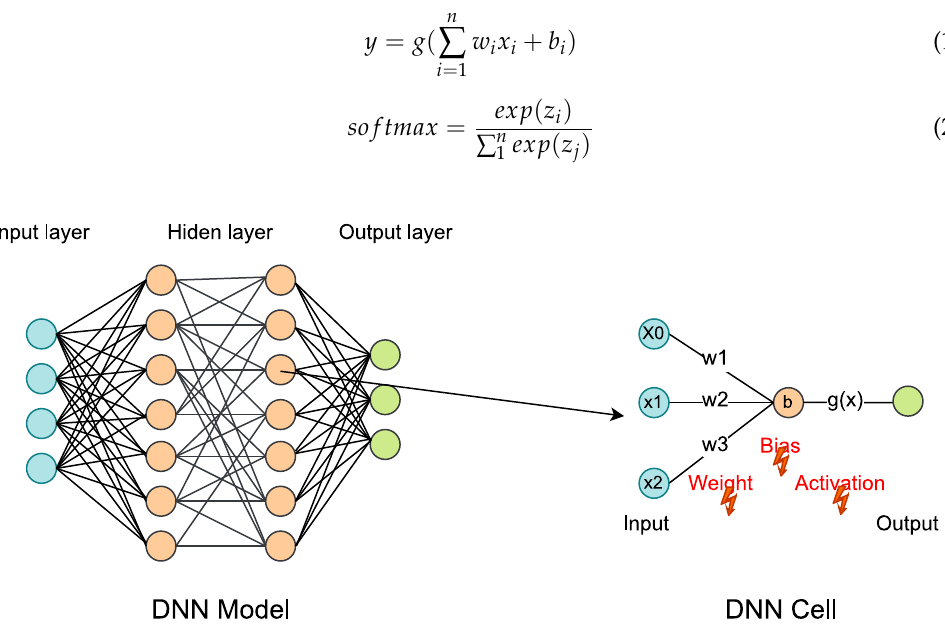
Figure 9. The structure of DNN model and the attackable parts in DNN